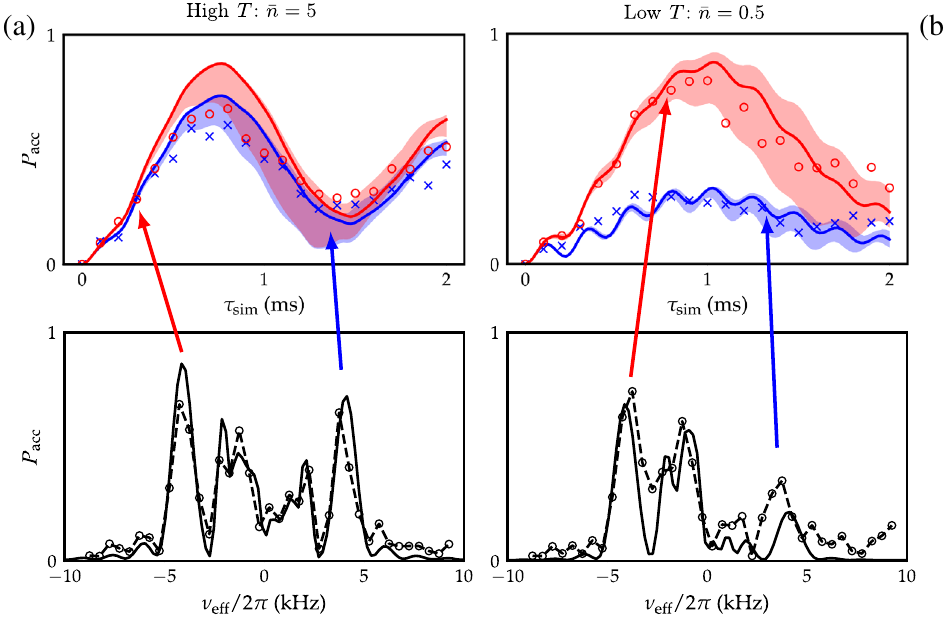
FIG. 2. Energy transfer probability to the acceptor P vs simulation time τ and vibrational frequency ν . Left (a) [right (b)] plots acc sim eff show the time dynamics at environmental temperature ¯ n ¼ 5 ( ¯ n ¼ 0 . 5 ). Upper plots show the time dynamics P with ν /2 π ≈ acc eff þ 4.56 kHz (blue points, ×) and ν eff /2 π ≈ − 4.56 kHz (red points, circles). The lower plots show P acc vs ν eff , where the simulation time τ is fixed to 0.7 ms. For all cases, f J; κ ; Δ g ¼ 2 π × f 1 . 30 ð 1 Þ ; 1 . 40 ð 4 Þ ; 4 . 56 ð 2 Þg kHz. Solid lines are numerical simulations of the sim system with all parameters determined through independent calibrations. The shaded regions represent the estimated systematic uncertainty on the theoretical curve, obtained from the measurement error in the calibration parameters. Note that the theory estimates include the effect that the detuning Δ fluctuates around its mean due to relative intensity noise of 0.02 as well as due to variations of the ion-laser coupling strength via finite-temperature effects. In (a), the standard deviation of the corresponding distribution is 2 π × 0 . 23 kHz, whereas in (b), it is 2 π × 0 . 1 kHz. Solid lines in the spectral plots represent a numerical solution where a small frequency offset adjusts for a systematic bias of the vibrational frequency measurements. In all plots, the statistical error is smaller than the markers. The measured data points in the spectral plots are connected with a dashed line to guide the